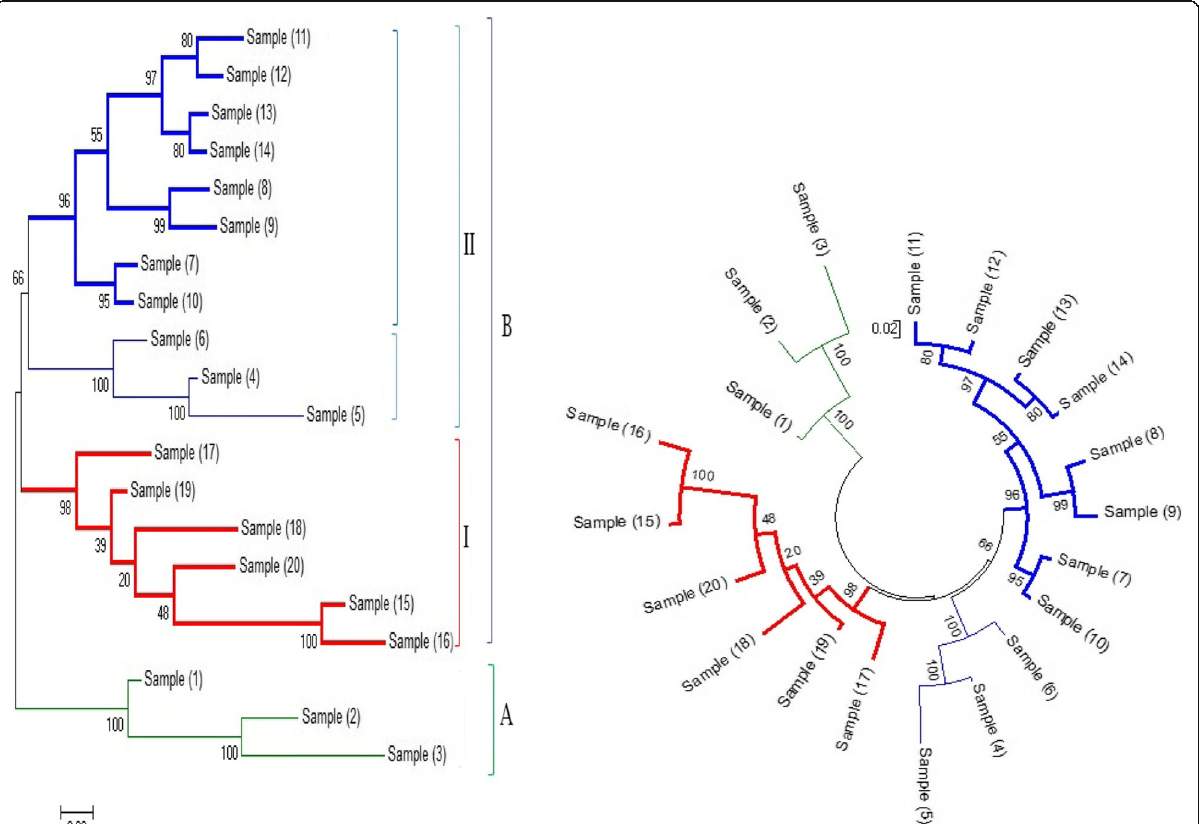
Fig. 3 Molecular phylogenetic analysis of different Triticum species by pairwise distance analysis depending on nucleotide sequence of partial matK gene. The phylogenetic analysis was performed in MEGA program version 6 by maximum likelihood method depending on the Tamura 3- parameter model. The tree had the highest log likelihood ( − 3290.1725). The tree ’ s percentage in which the associated species clustered together is shown next to the branches. Initial tree(s) for the heuristic search were performed automatically by applying Neighbor-Join and BioNJ algorithms to a matrix of pairwise distances evaluated using the maximum composite likelihood (MCL) approach and then selecting the topology with superior log likelihood value. The tree is drawn to scale with branch lengths measured in the number of substitutions per